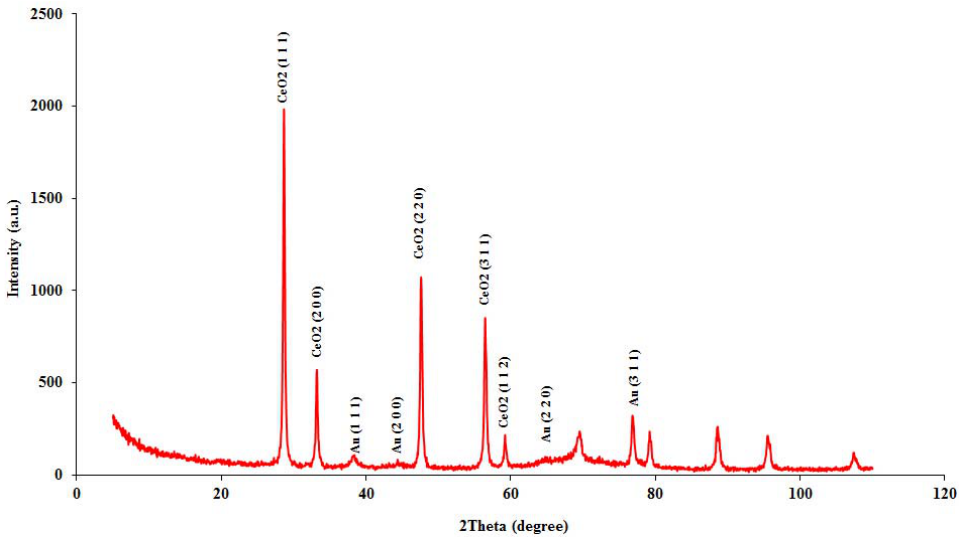
Figure 2. XRD pattern of AuSNPs/CeO